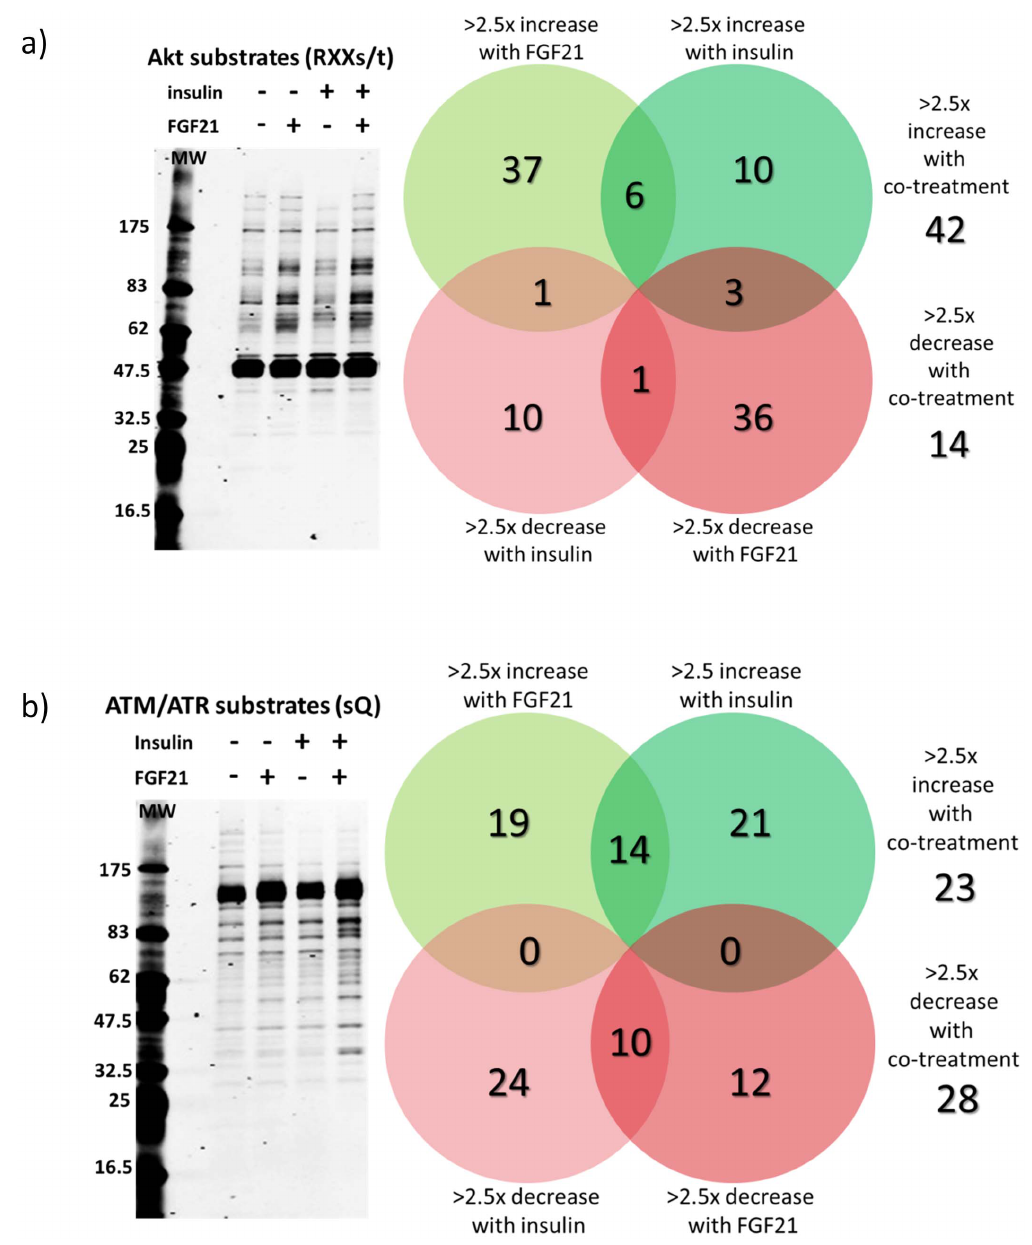
Figure 6. FGF21 and insulin synergistically induced phosphorylation of Akt substrates and ATM/ATR substrates. hASC-adipocytes were treated with FGF21 (10 nM) either alone or in combination with insulin (10 nM) for 30 min prior to harvest. hASC-adipocytes. a ) Levels of phosphorylation of Akt substrates were assessed by western blot using a phospho-specific antibody recognizing proteins with the motif RXX(s/t). b ) Levels of phosphorylation of ATM/ATR substrates were determined using a phospho-specific antibody recognizing proteins with the motif